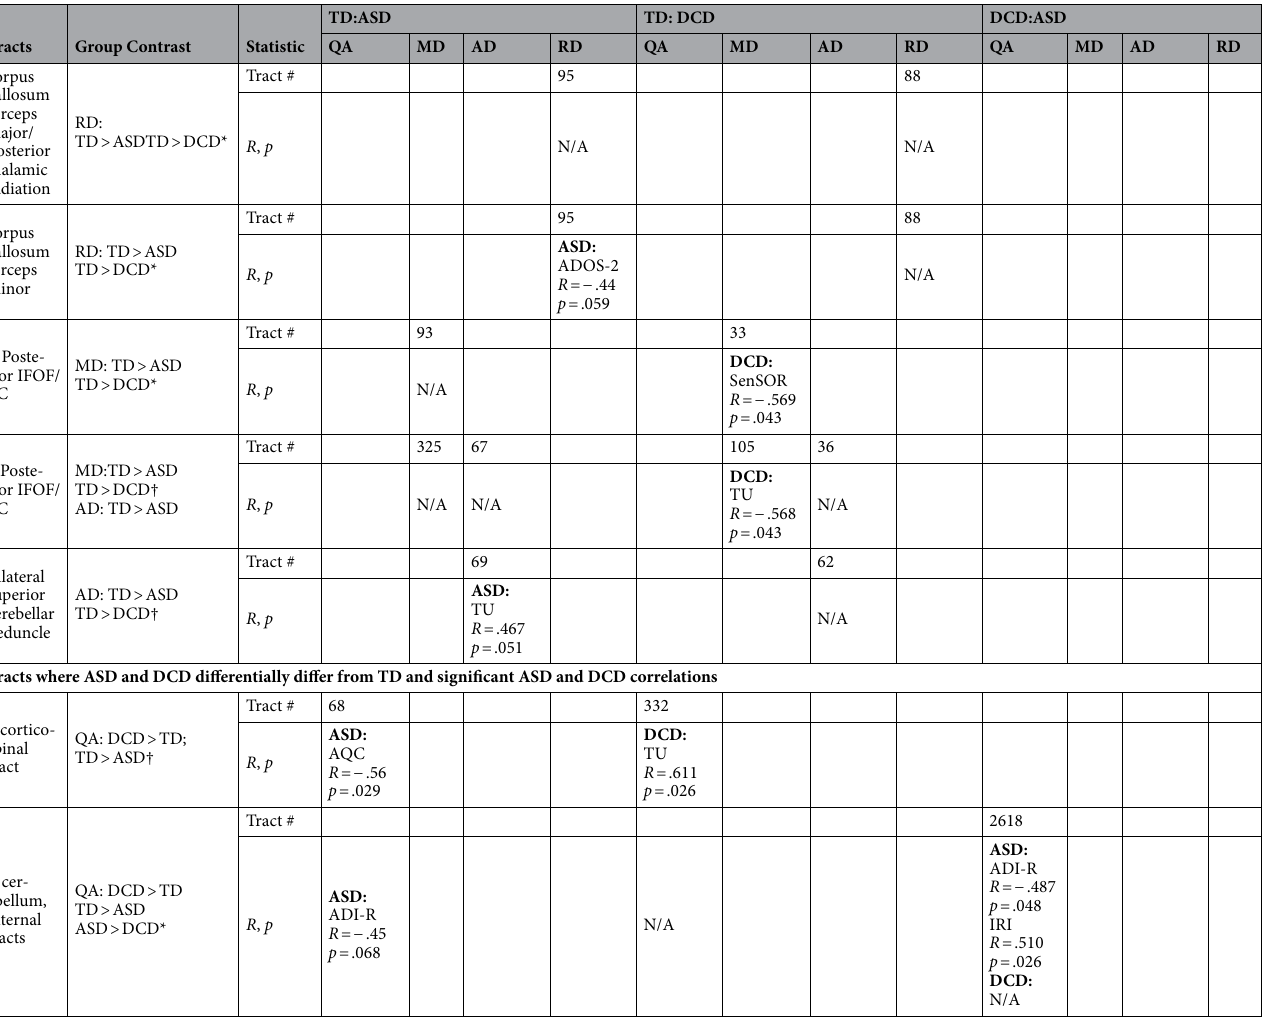
Table 3. Significant DCD Specific Differences, TD > ASD/DCD Differences, and Between group differences. * = good-moderate overlap between group comparison tracts, † = moderate overlap between group comparison tracts; cortico-descending consists of both cortico-spinal and cortico-pontine tracts. p > .05; ASD = autism spectrum disorder; DCD = developmental coordination disorder; TD = typically developing; L = left; R = right; QA = quantitative anisotropy; MD = mean diffusivity; AD = axial diffusivity, and RD = radial diffusivity; AQC = Alexithymia Questionnaire for Children 2-factor Total; SRS = Social Responsivity Scale-2 Total Score; RBS Total = Repetitive Behaviors Scale Total Score; SenSOR = Sensory Over-Responsivity Scale Total Score; MABC-2 Total = Movement Assessment Battery for Children-2 Total Score; CCR = Connors Child Report Total Score; GTC = gesture to command; IMI MF = imitation of meaningful gestures; IMI ML = imitation of meaningless gestures; TU = tool use; ADOS-2 = Autism Diagnostic Observational Scale-2 Comparison Score; ADI-R RSI = Autism Diagnostic Interview Revised, Reciprocal Social Interactions